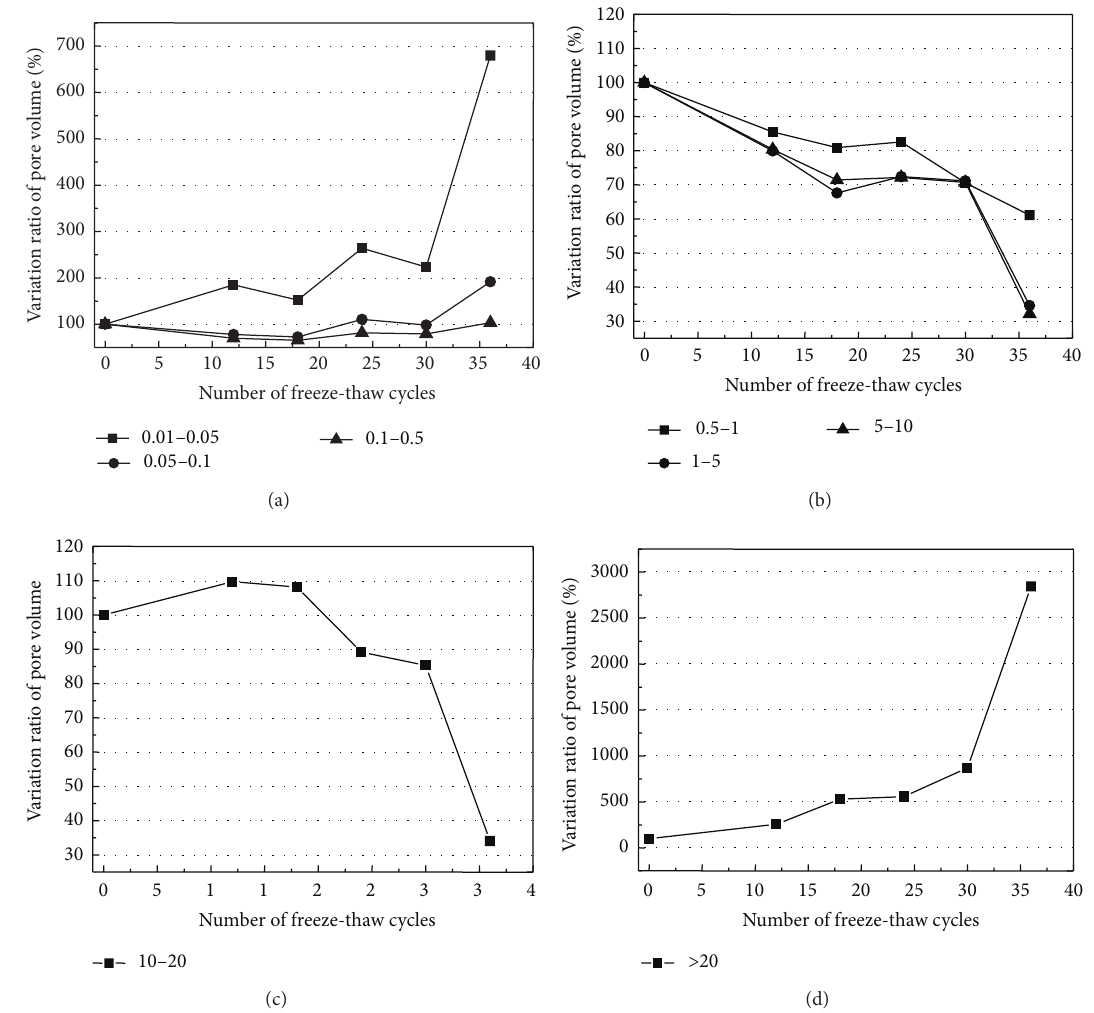
Figure 8: Variation ratio of pore volume of Φ 75 mm circle region of